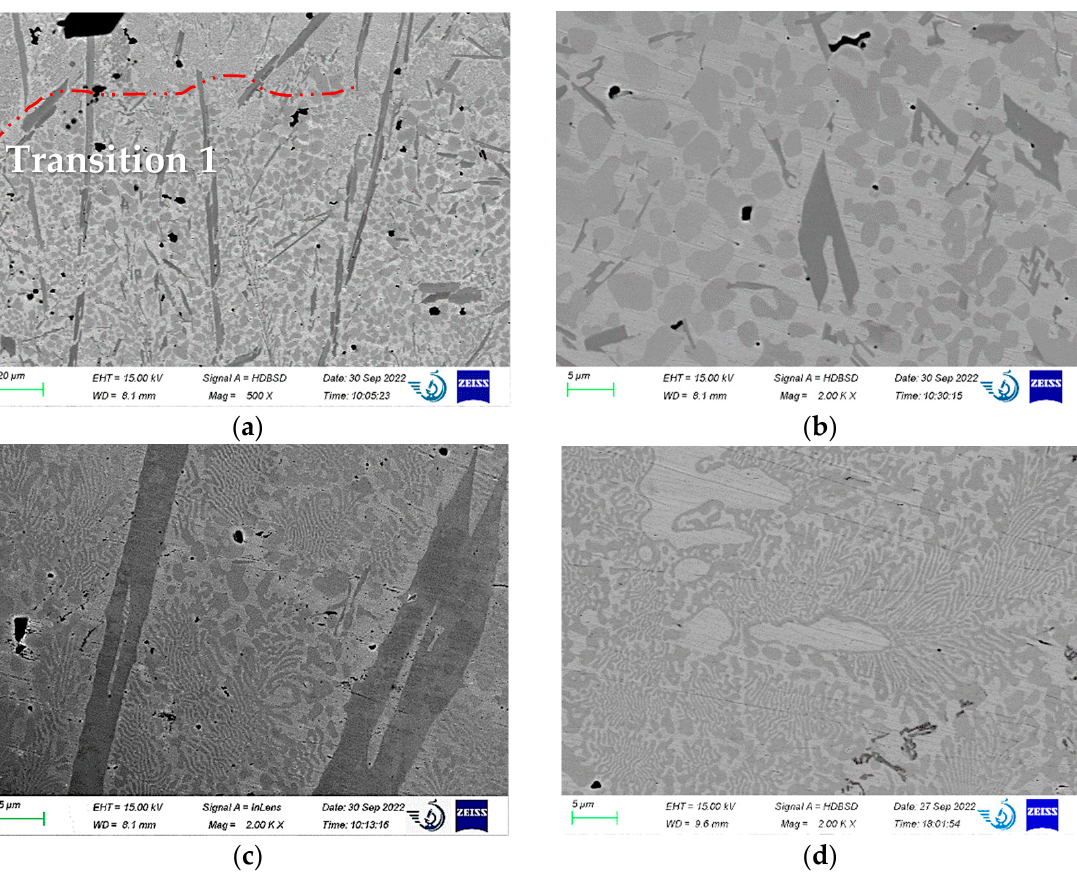
Figure 5. Microstructure of the coating: ( a ) transition layer 1–weld 2 interface, ( b ) microstructure of the transition zone (below the red line in ( a )), ( c ) microstructure of the weld just above the transition layer (above the red line in Figure 3a), and ( d ) typical microstructure of the central part of the weld.